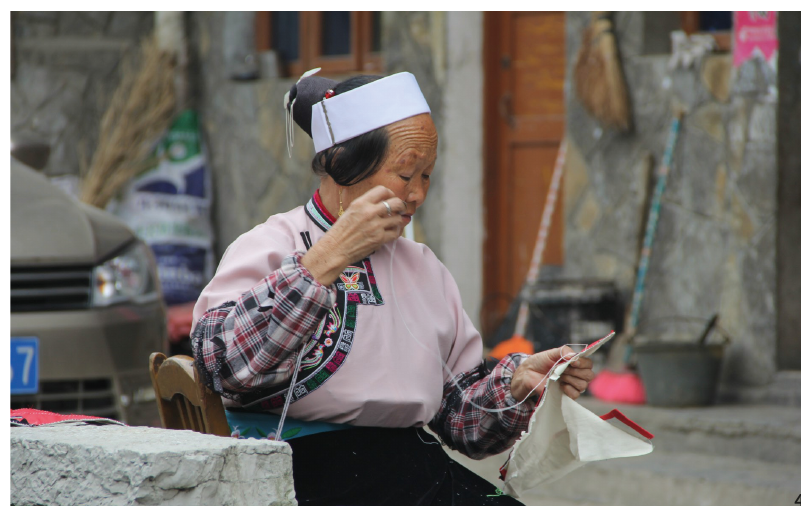
Figure 4 A female handicraft worker making embroidery in rural Anshun, Guizhou Province (Source: MOMA Design Company)